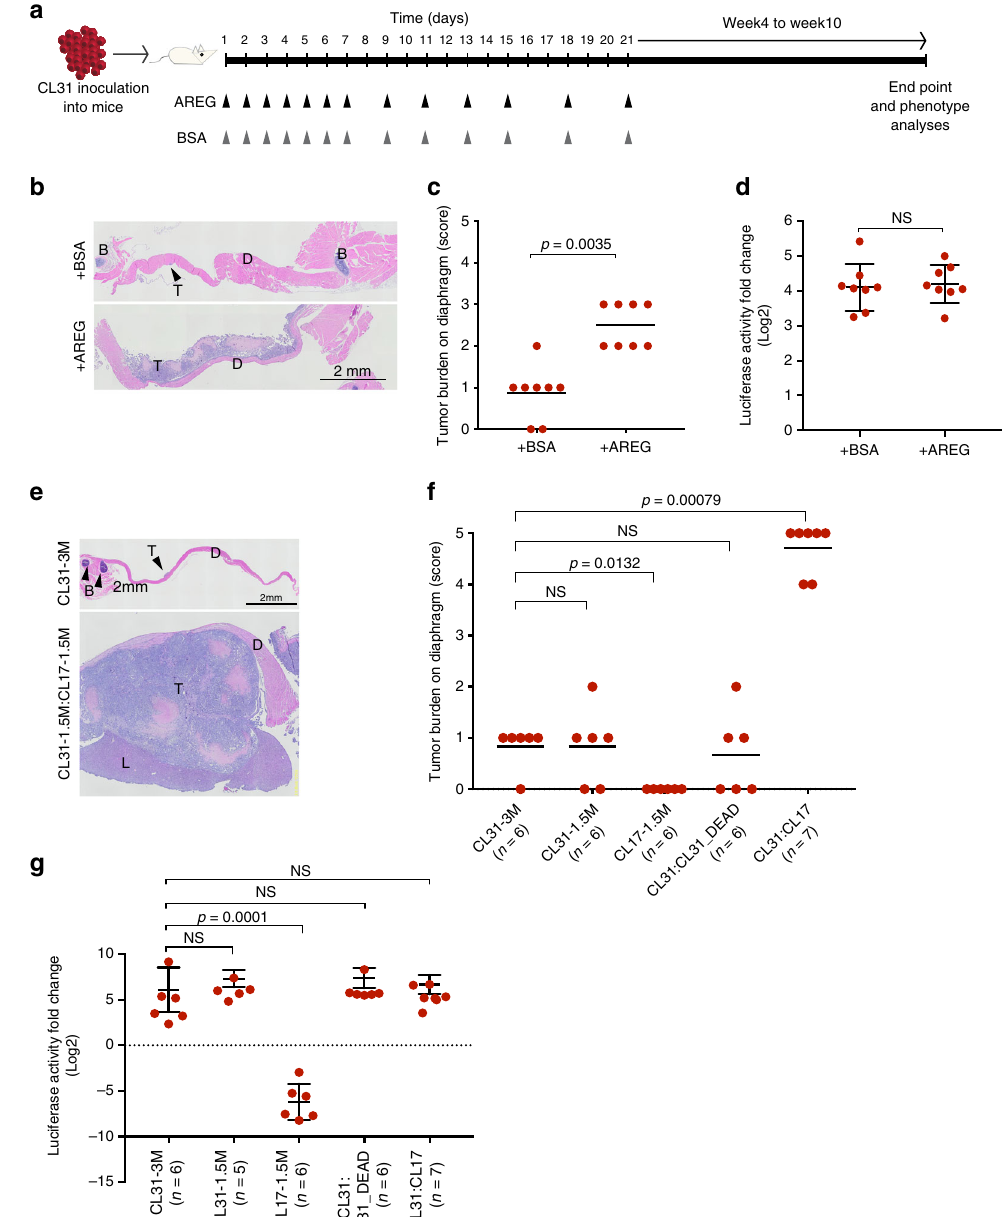
Fig. 5 Transient exposure to CL17 or AREG is suf fi cient to promote peritoneal metastasis of CL31. a Schematic depiction of experimental design of short-term supplementation with human recombinant AREG in vivo. b Representative H&E images of diaphragms collected from mice at the 10-week end point supplemented with AREG or BSA vehicle control as depicted in ( a ), representative images from one of two independent experiments. T tumor cells, D diaphragm, B bone. Scale bar, 2 mm. c Tumor burden score of solid metastases on the diaphragm generated by CL31 in mice treated with AREG or BSA vehicle control. Data from two independent experiments, total n = 8 mice. p Value was computed using the chi-square test with Monte Carlo simulation. d Fold change in luciferase activity in blood samples collected from individual mice at the end point (10 weeks) relative to the 24-h time point. Data from two independent experiments (total n = 8 mice) and shown as mean ± SD. p Value was computed using the Mann – Whitney test, two-tailed. NS not signi fi cant. e Representative H&E images of the diaphragms of mice inoculated with CL31 alone (3 × 10 6 cells) or a 1:1 mixture of CL31 and CL17 (3 × 10 6 total cells). T tumor cells, D diaphragm, L liver, B bone. Scale bar, 2 mm. f Tumor burden score of solid metastases on the diaphragm generated by the indicated cell inocula. Data from two independent experiments (total n = 6 – 7 mice) and shown as mean ± SD. p Values were computed using the chi- square test with Monte Carlo simulation. NS not signi fi cant. g Fold change in luciferase activity in blood samples collected from individual mice at the end point (10 weeks) relative to the 24-h time point. Data from two independent experiments (total n = 6 – 7 mice) and shown as mean ± SD. p Values were computed using the one-way ANOVA test and Dunnett ’ s multiple comparison test. NS not signi fi